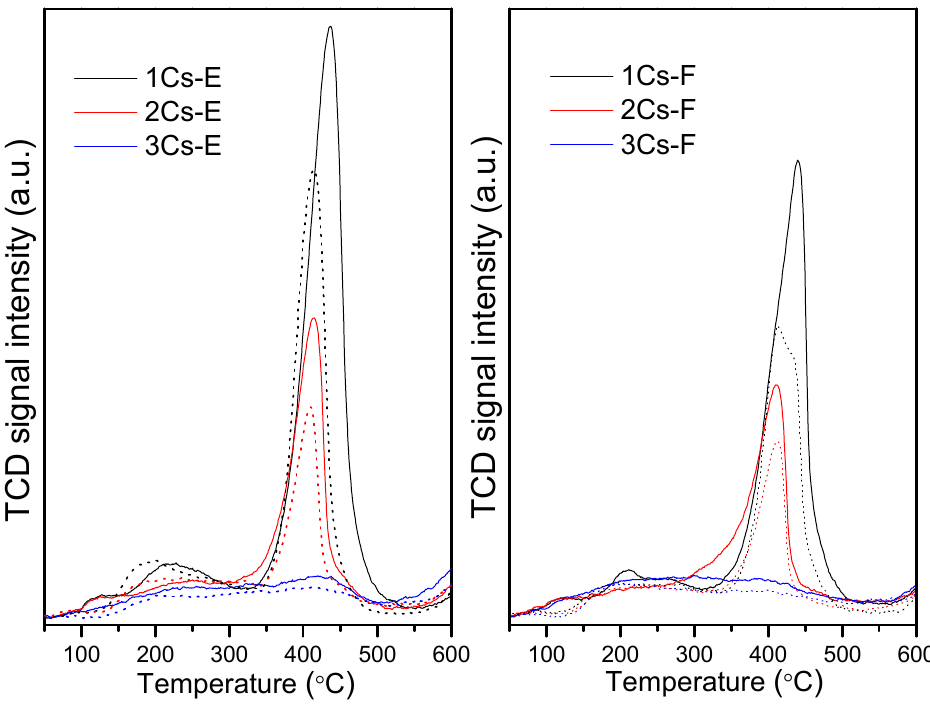
Figure 4. NH 3 temperature ‐ programmed desorption (NH 3 ‐ TPD) profiles of the samples. Table 2. The contents of NH 4 + and H + in the compounds calculated from NH 3 ‐ TPD.